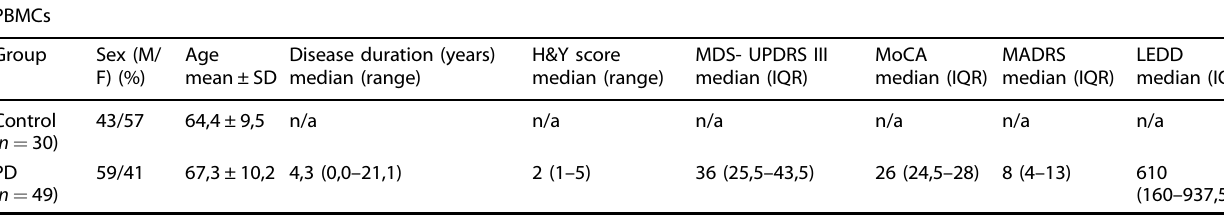
Table 1. Demographical and clinical characteristics of all subjects who participated in this research.